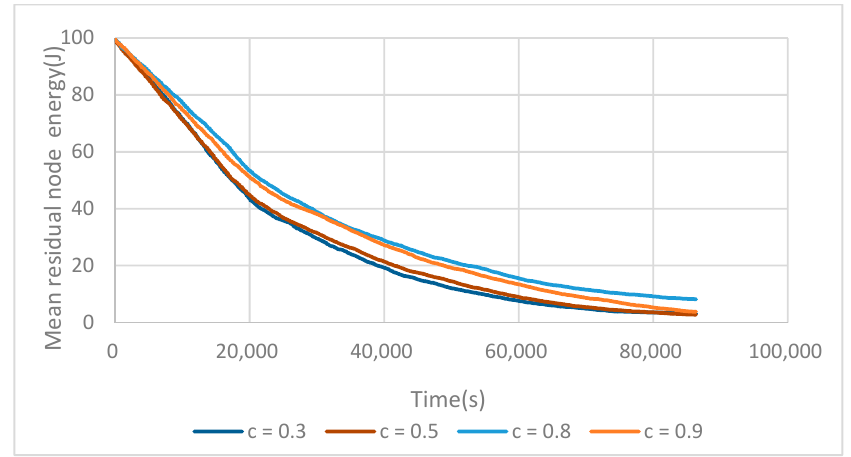
Figure 6. Evolution of M E (t) depending on the C value.